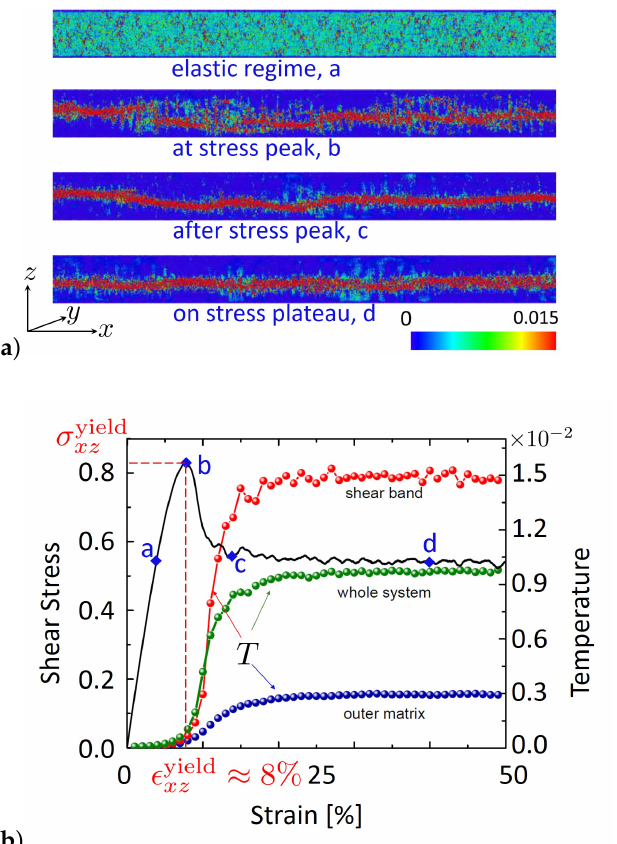
Figure 1. ( a ) Snapshots of the spontaneous shear strain (obtained during a time interval corresponding to 1% imposed global strain) during characteristic stages of shear deformation. The local shear strain first builds up homogeneously during the early elastic regime, where shear stress linearly grows with the externally imposed strain. A shear band is then formed as the stress reaches a maximum value. The shape of this SB slightly fluctuates during further stages of deformation (c, d), but its overall structure remains unchanged. The stress states corresponding to these snapshots are marked by blue diamonds, and the letters a, b, c and d on the stress-versus-strain plot in panel ( b ). The color bar gives the strain magnitude. These images (adapted) are taken from [21]. ( b ) The evolution of system averaged shear stress and temperature in the course of deformation is shown. For T , the corresponding data within the shear band and in the outer matrix (the region outside the shear band excluding walls) are also shown. The observation of a higher temperature inside SB is in line with the idea that heat is primarily generated there as compared to other parts of the sample. Note that T varies roughly by a factor of five between SB and the outer